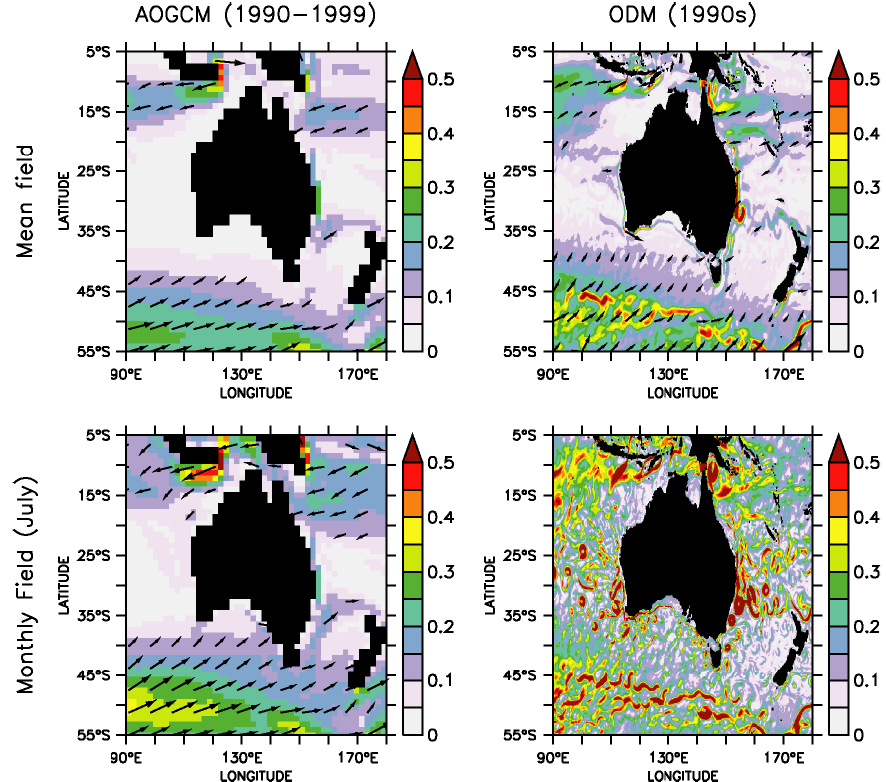
Fig. 2. Comparison of the surface currents from AOGCM (left column) and ODM (right). Shown are 10-year mean (top row) and monthly snapshots (bottom) of surface current velocity. Colours show the velocity magnitude (in ms − 1 ), arrows indicate